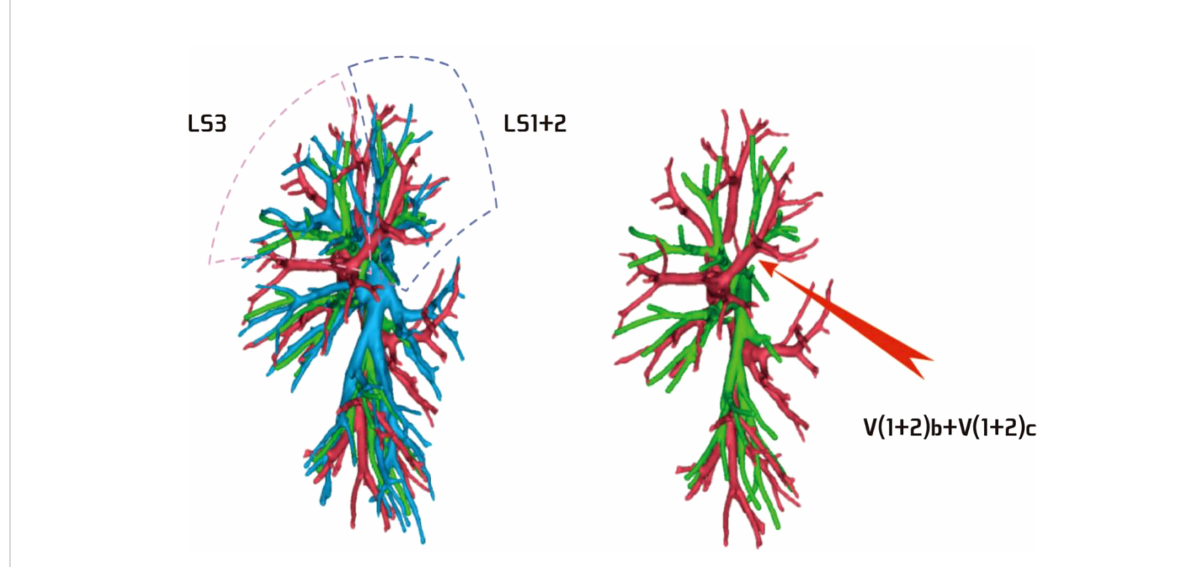
FIGURE 11 Descending central vein type: V(1 + 2)b + c back fl ow trunk walking below